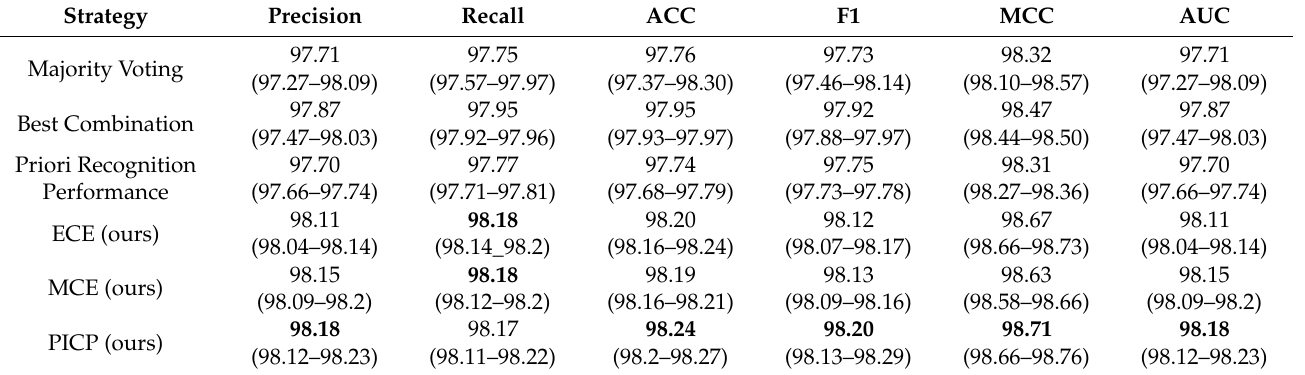
Table 4. Performance (in %) of ensembled models on unseen